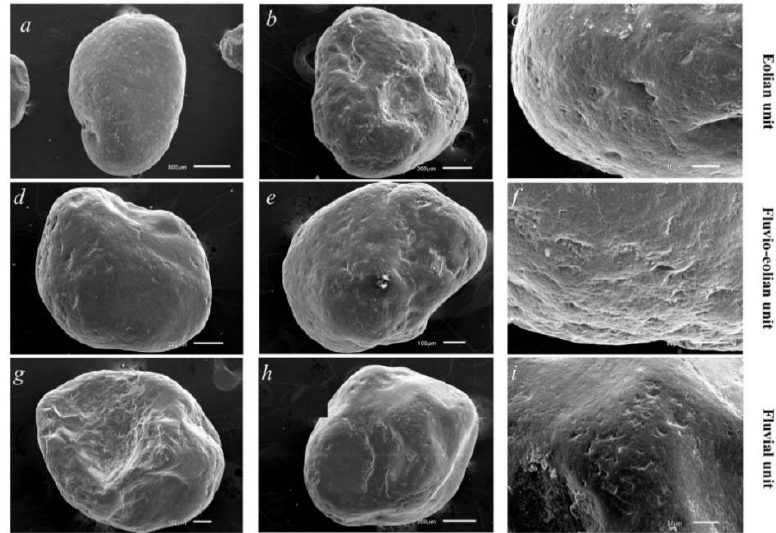
Figure 4. SEM photographs of representative quartz grains from different complexes of the TK1 section: ( a ) rounded matt grain with micro-pitted surface; ( b ) chemically weathered grain; ( c ) micro-pitted chemically weathered surface; ( d ) half-matted grain with signs of both pit and micro-pitted surface structure; ( e ) half-matted grain with micro-pitted surface structure and signs of mechanically induced features; ( f ) matte grain with signs of etching and both fine-pitted and micro-pitted surface structure; ( g ) half-matted etched grain with fine-pitted surface structure; ( h ) and ( i ) glossy grain with fine-pitted surface structure.